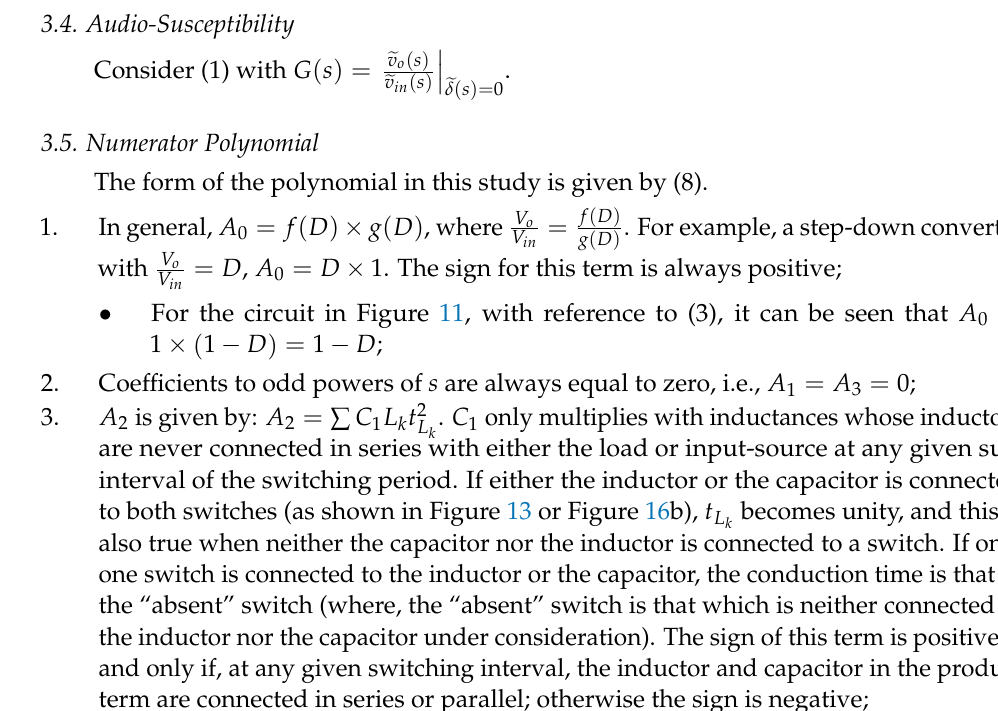
Figure 16. Group G canonical-cell ( a ) and capacitor double switch connection ( b ).